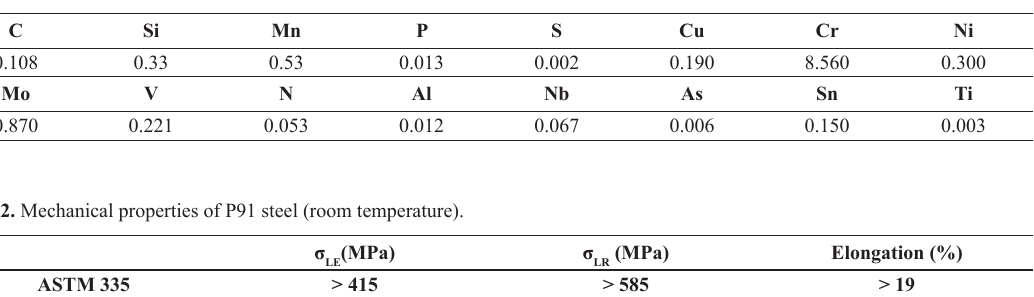
Table 1. Chemical composition of P91 steel (% weight).